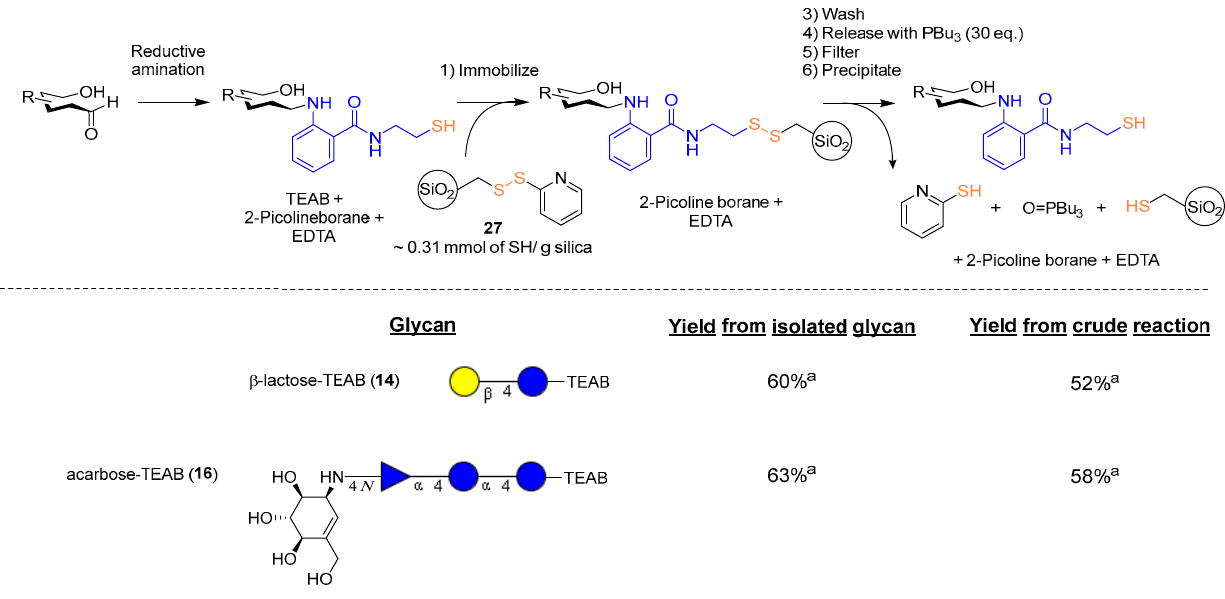
Figure 6. ‘Catch and release’ of TEAB-labeled glycans. (a) Isolated yield.